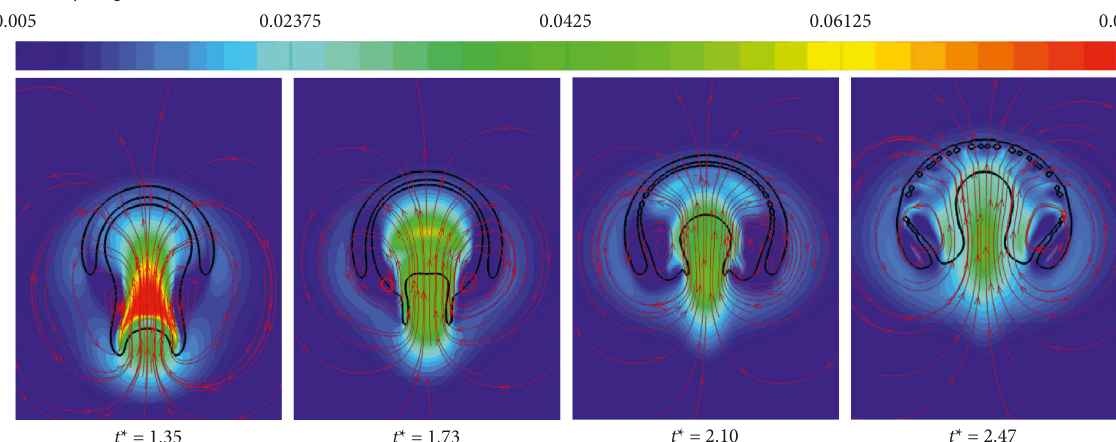
Figure 5: Coalescence process between two bubbles and corresponding flow field at Bo � 50, Ar � 80, ρ